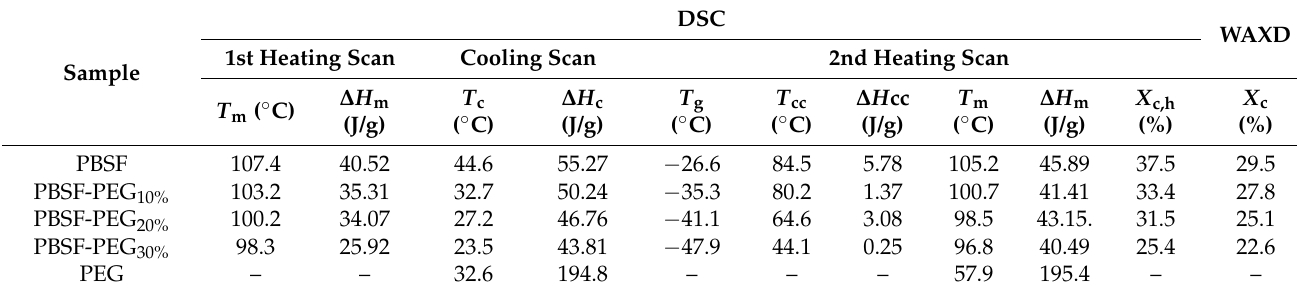
Table 2. Thermal properties of PBSF and